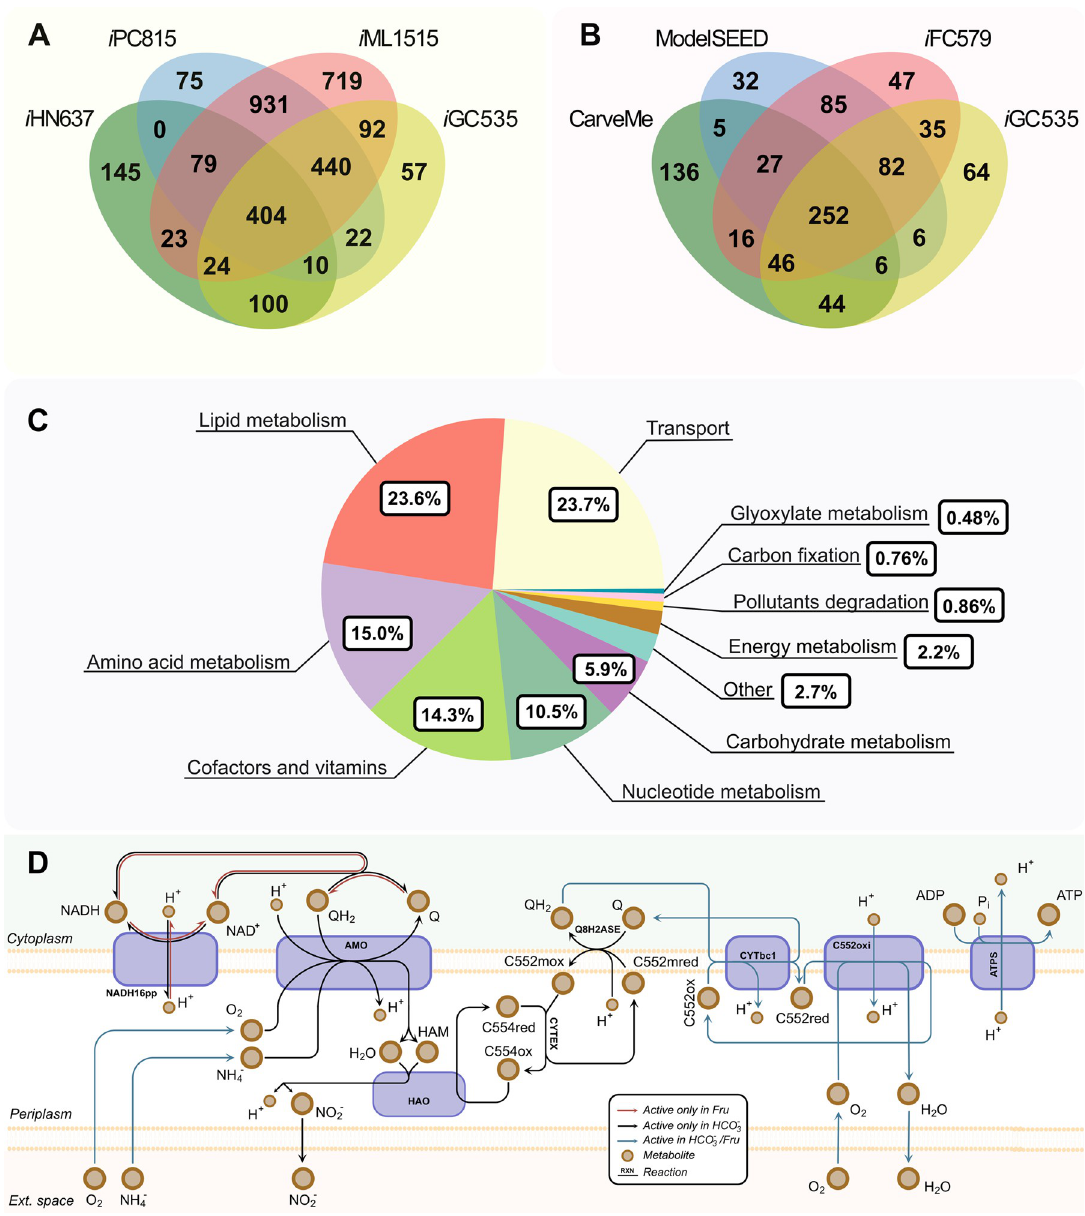
Fig 1. Features of i GC535. (A) Comparison of shared reactions among i GC535 and template models ( i HN637, i PC815, i ML1515). (B) Comparison of shared genes among i GC535 and other Ne models. (C) Reactions distribution through the subsystems in the genome- scale model. (D) Electron transport chain simulated using fructose at high concentrations or HCO 3- as the sole carbon source. Abbreviations: NADH16pp, NADH dehydrogenase; AMO, ammonia monooxygenase; HAO, hydroxylamine oxidoreductase; CYTEX, cytochrome exchange; Q8H2ASE, ubiquinol synthase; CYTbc1, CytCbc1 reductase using ubiquinol-8; C552oxi, cytochrome c552 oxidase; ATPS, ATP synthase; QH 2 , ubiquinol; Q, ubiquinone; HAM, hydroxylamine; C554red, cytochrome c554 reduced; C554ox, cytochrome c554 oxidized; c552mox, membrane cytochrome c552 oxidized; c552mred, membrane cytochrome c552 reduced; C552ox, cytochrome c552 oxidized; C552red, cytochrome c552 reduced; Fru, fructose.